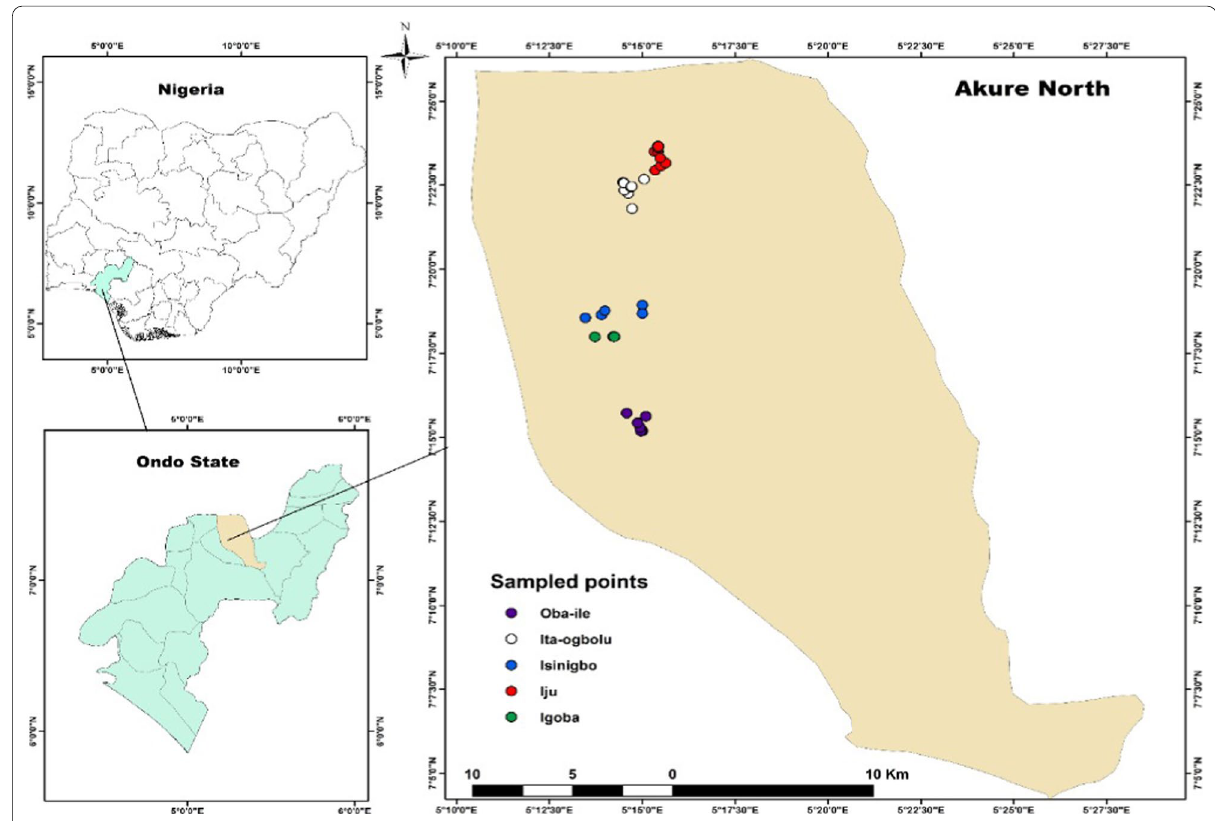
Fig. 1 Map of Akure North Local Government Area showing the sample collection